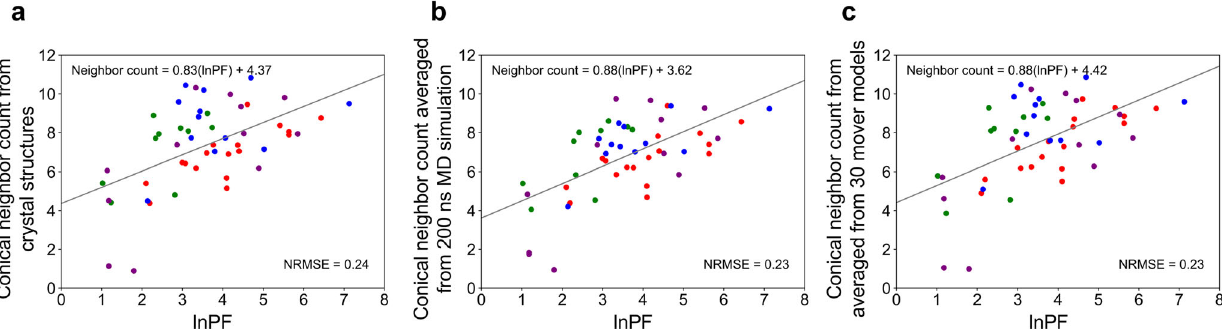
Fig. 1 Correlations of the natural logarithm of the protection factor with conical neighbor count using residue types WYFHL. The line of best fi t, equation of the line, and the NRMSE value are included in the plot. The labeled residues are color-coded by protein. Myoglobin labeled residues are red, calmodulin green, lysozyme blue, and LMPTP purple. a Conical neighbor count was calculated from crystal structures of benchmark proteins. b Conical neighbor count was averaged over every frame of a 200 ns MD simulation. c Conical neighbor count has averaged over 30 Rosetta mover models per benchmark